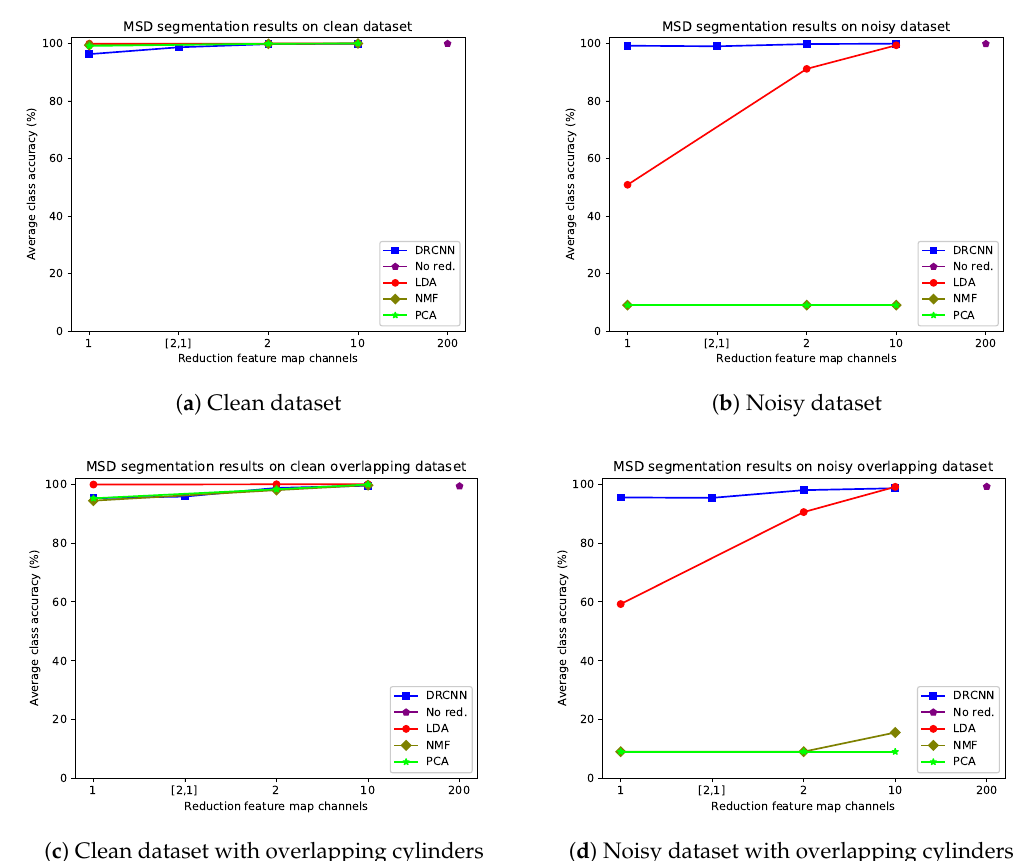
Figure 14. Average class accuracies for different reduction schemes with MSD as CNN for different simulated remote sensing datasets: clean dataset ( a ), noisy dataset ( b ), clean overlapping dataset ( c ) and noisy overlapping dataset ( d ). The layered reductions to 2 and then 1 feature map channel(s) are indicated by [ 2,1 ]